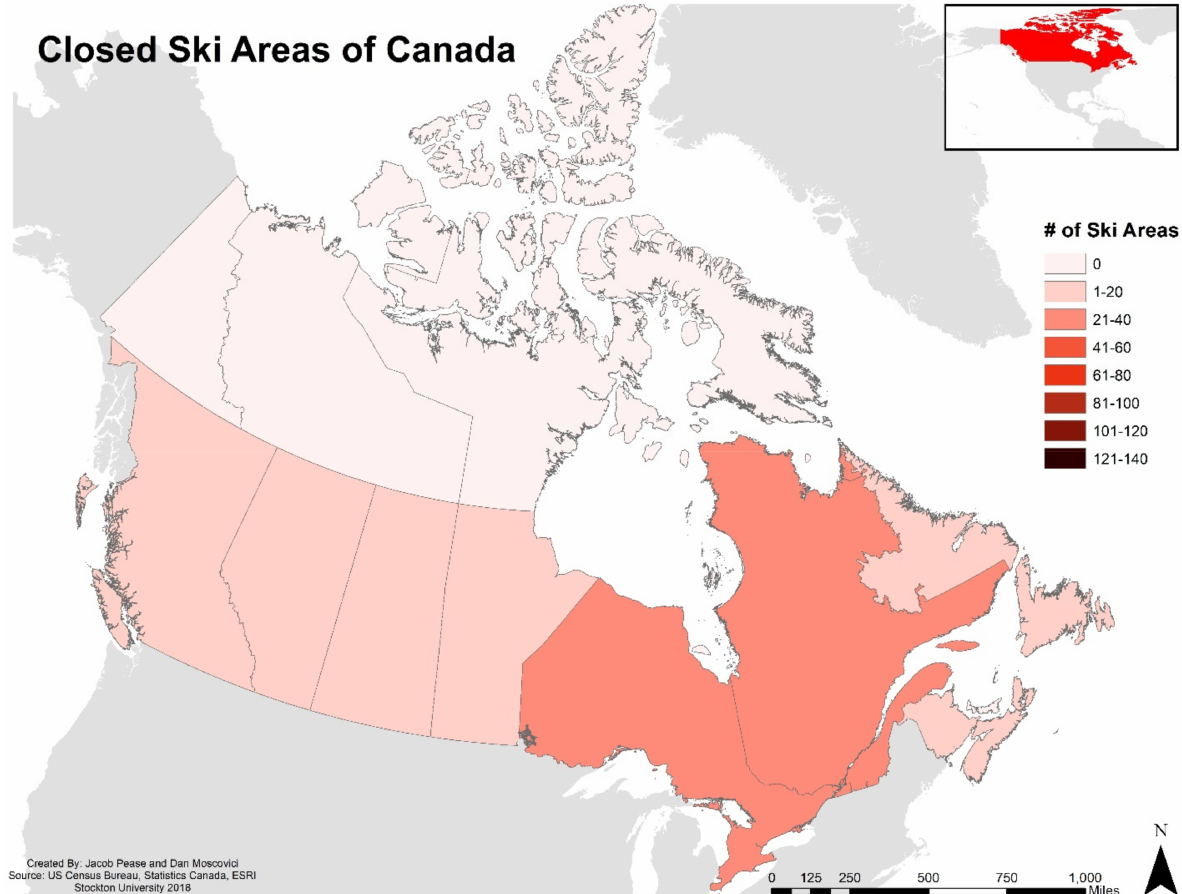
Figure 2. Number of ski resorts of Canada that were closed during the years